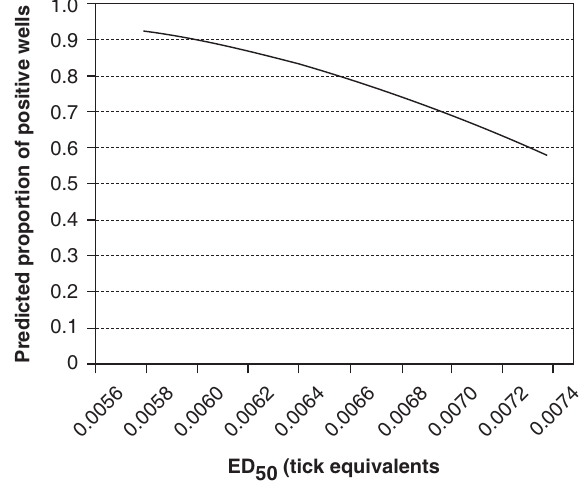
FIG. 3 Titration curves of Katete-K2g (——) and K2s (-----) stabilates stored on ice for 0 (control), 6, 12 and 24 h (from left to right). (ln t.e.) is the natural log of the stabilate dose expressed in tick equivalents